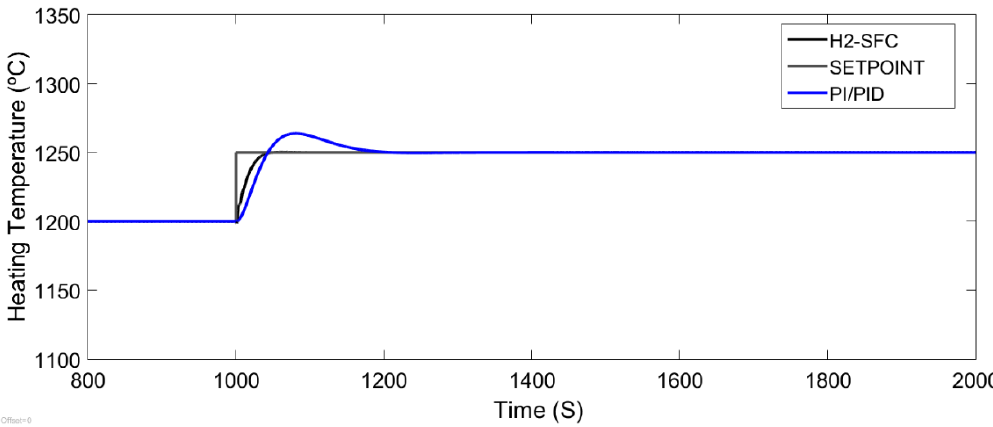
Figure 6. Time responses of the conventional (PID) and H2-SFC control system with internal step reference.